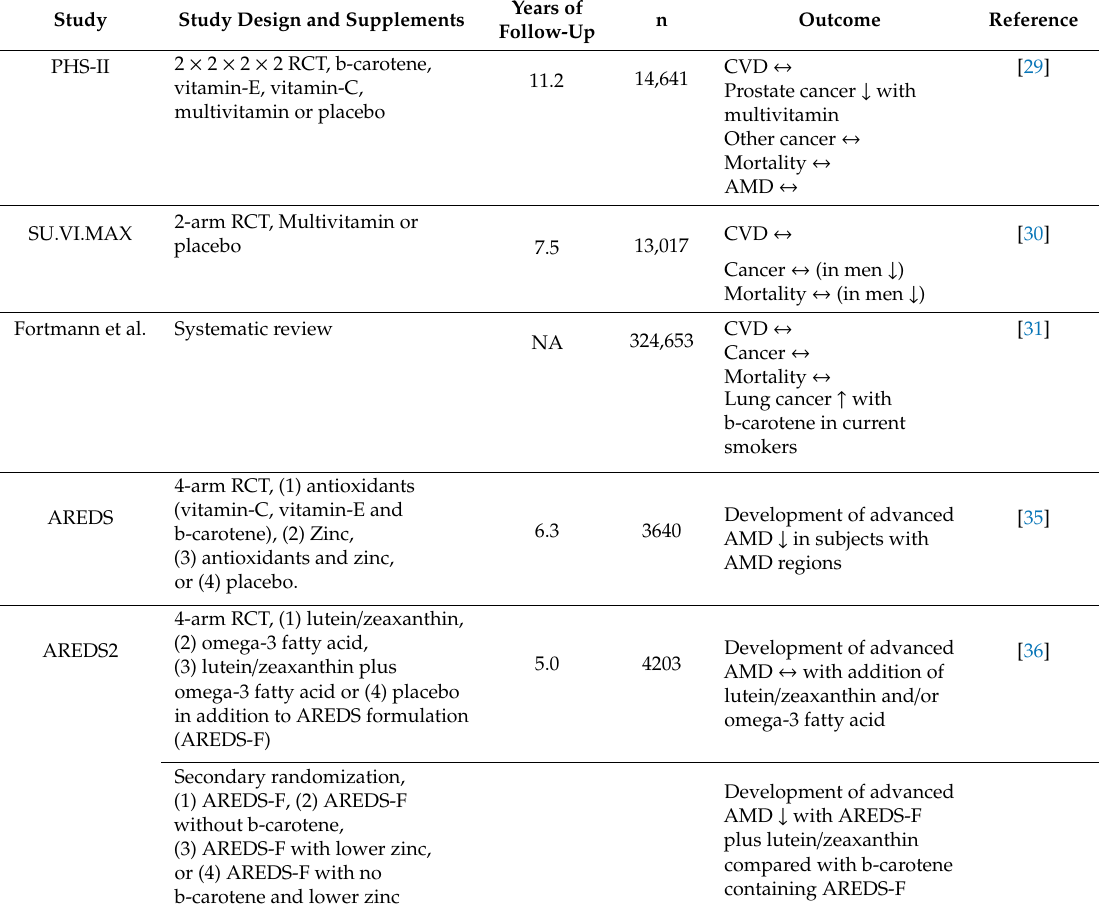
Table 1. Treatment outcomes of anti-oxidant supplements in cardiovascular disease (CVD), cancer, and age-related macular degeneration (AMD).